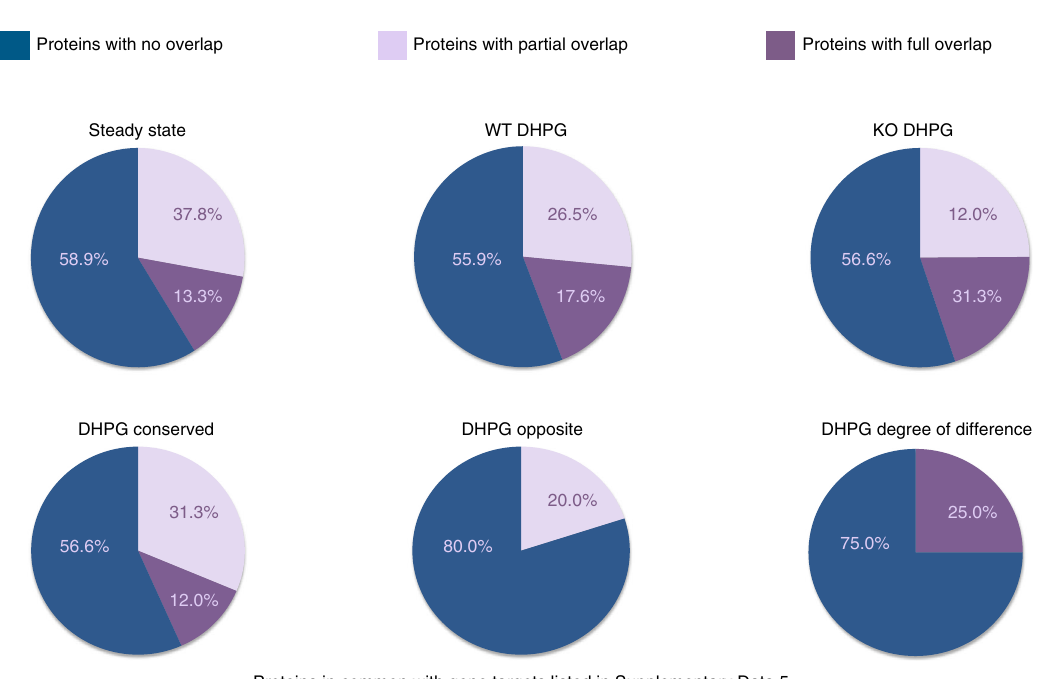
Fig. 3 Steady state and mGluR-stimulated de novo proteomes differ in Fmr1 knockout mice. a Venn diagram of proteins measured in steady state, wild-type (WT) DHPG and Fmr1 knockout (KO) DHPG BONLAC experiments. We noted that despite many proteins measured in common, there is limited overlap in proteins being made, suggesting distinct de novo proteomic responses at steady state and in response to DHPG treatment. b Pie charts of the top 50 FMRP targets from HITS-CLIP 24 and the consistently changed proteins in steady state, WT DHPG and FXS DHPG BONLAC studies. c Pie charts of top ASD genes and the BONLAC experiments (source of gene lists are in Supplementary Data